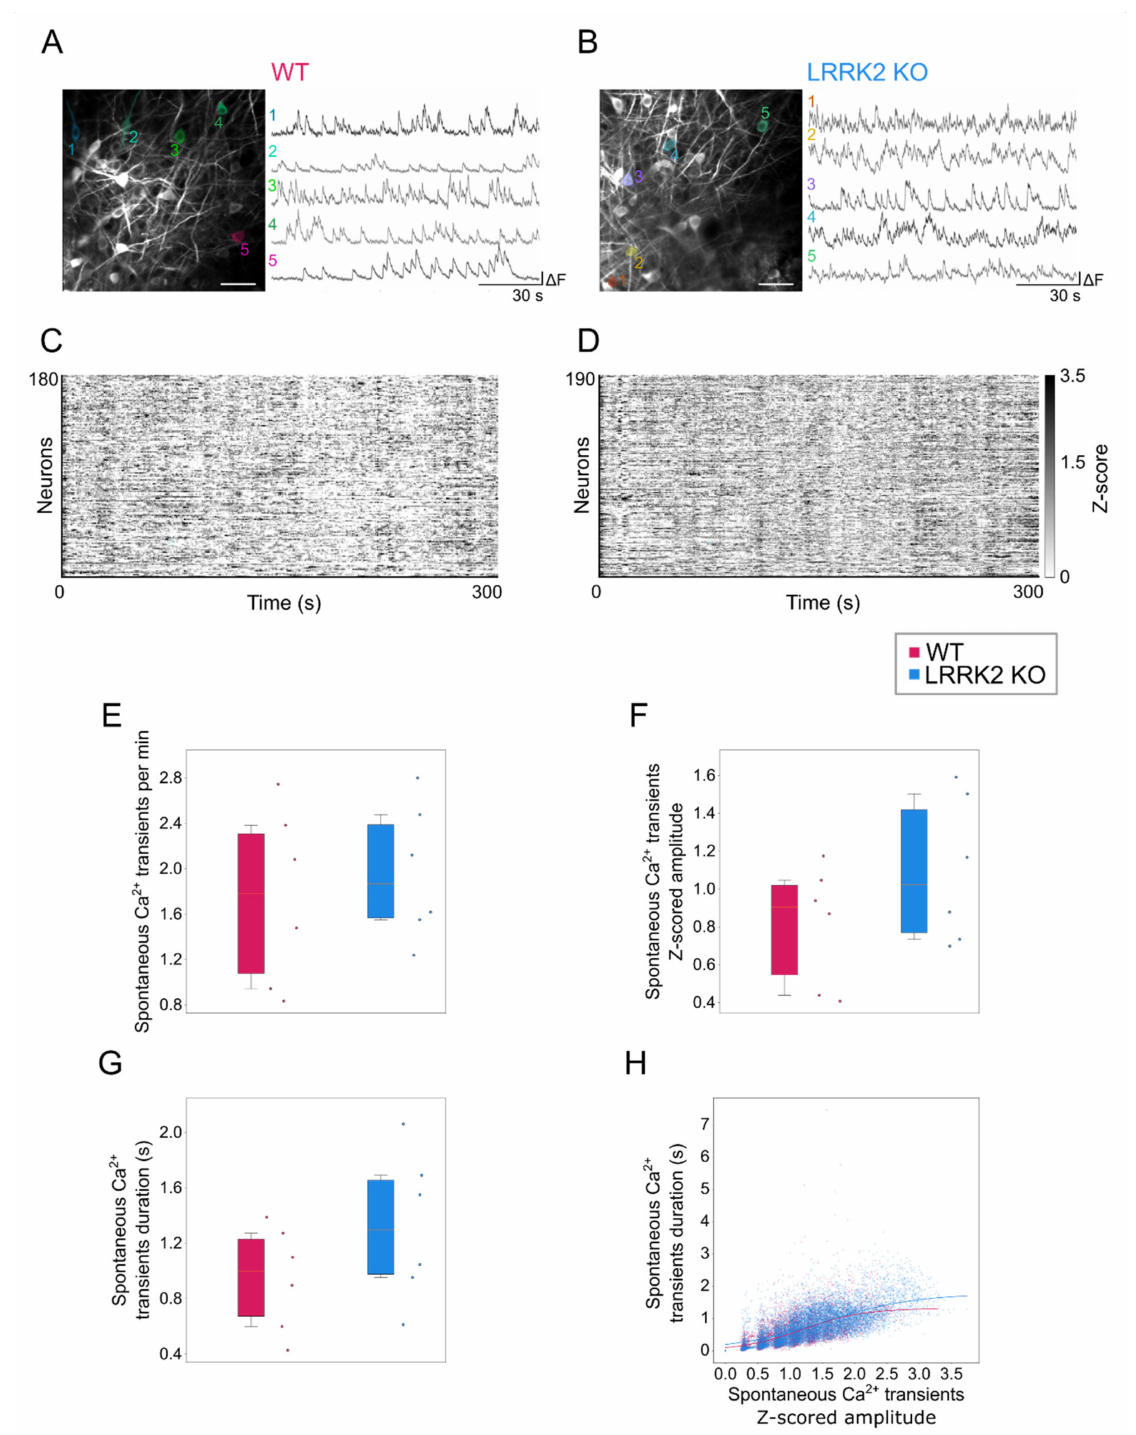
Figure 3. Mitral cells spontaneous activity in the OB is not affected by LRRK2 KO mutation. ( A , B ) Representative two- photon average projection images in vivo of GCaMP6s-expressing mitral cells (left) and spontaneous Ca 2+ activity traces of the neurons highlighted (right) recorded in the OB of one WT (A) and one LRRK2 KO (B) mouse. Scale bars = 100 µ m. ( C , D ) Raster plots of spontaneous Ca 2+ activity of the mitral cells showed in A, B, respectively. ( E – G ) Quantification of the frequency (E), amplitude (F), and duration (G) of spontaneous Ca 2+ transients in WT and LRRK2 KO mice. Statistics are calculated on mice populations. Error bars = 5th to 95th percentile. ( H ) Scatter plot showing the correlation between mean amplitude and mean duration of spontaneous Ca 2+ transients for each neuron in WT and LRRK2 KO mice. The continuous lines indicate the fitted sigmoid curve (WT asymptote at duration = 1.31 s; LRRK2 KO asymptote at duration = 1.78). Statistics are calculated on cell